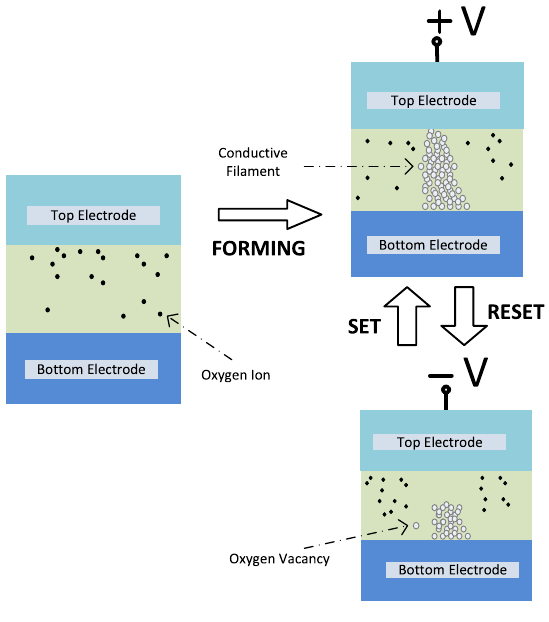
Fig. 6 Schematic illustration of switching mechanism of